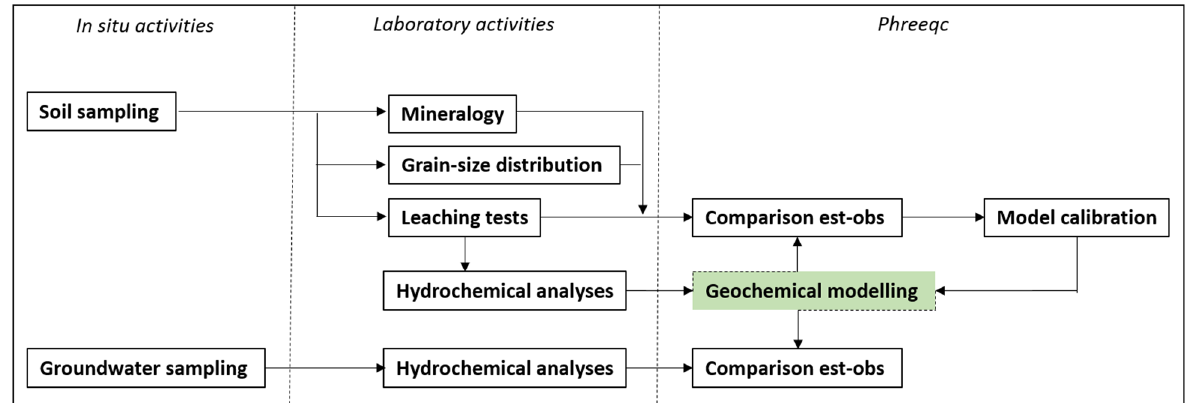
Figure 4. Flowchart of the methodology used in this work (modified after [11]).